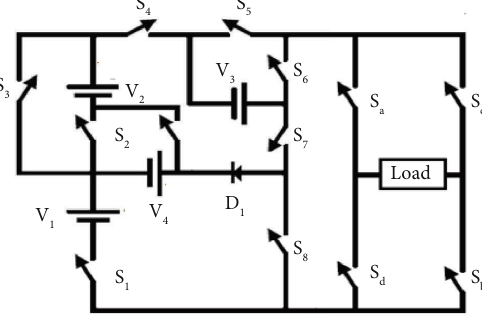
Figure 2: Proposed nine-level